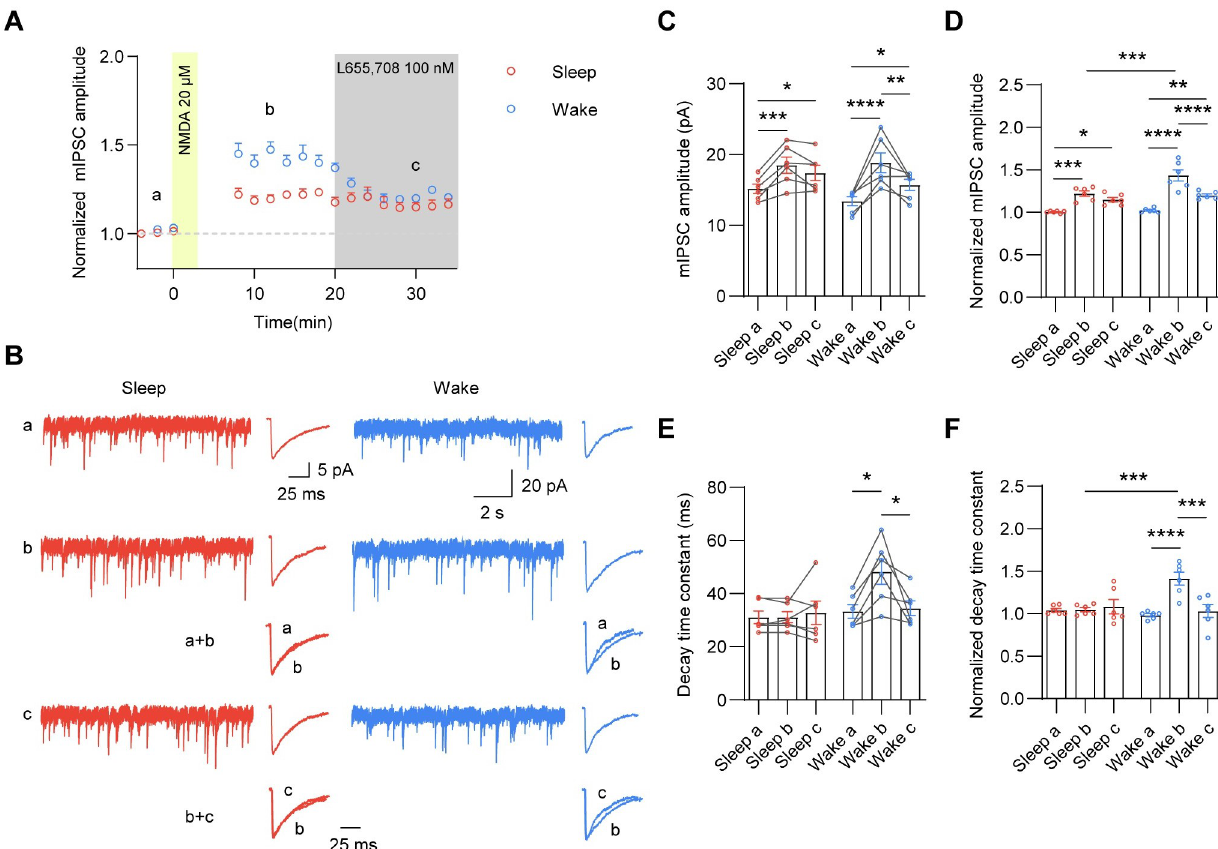
Fig 3. Synaptic recruitment of α 5-GABA A Rs contributes to wake-dependent enhancement of iLTP. (A) Time course of mIPSC amplitude in hippocampal CA1 pyramidal cells before and after NMDA application. α 5-GABA A R inverse agonist L655,708 was applied 20 min post-NMDA application. The data were binned into 2-min time bins. (B) Representative mIPSC traces and average mIPSC traces at indicated time points in (A) from the CA1 pyramidal neuron in acute hippocampal slices prepared from sleep and wake mice. a+b indicated peak-scaled overlays showing the difference of decay time constants between time points a and b. b+c indicated peak-scaled overlays showing the difference of decay time constants between time points b and c. (C) L655,708 decreased mIPSC amplitude after NMDA application in wake mice but not sleep mice. ( n = 6, 2-way ANOVA, F (2, 20) = 34.77, p < 0.0001 with Sidak’s multiple comparison test, Sleep a versus Sleep b, p = 0.0007; Sleep a versus Sleep c, p = 0.0213; Wake a versus Wake b, p < 0.0001; Wake b versus Wake c, p = 0.0164; Wake a versus Wake c, p = 0.0013). (D) L655,708 decreased the potentiation of mIPSC amplitude after NMDA application in wake mice but not sleep mice. ( n = 6, 2-way ANOVA, F (2, 30) = 5.215, p = 0.0114 with Sidak’s multiple comparison test, Sleep a versus Sleep b, p = 0.0003; Sleep a versus Sleep c, p = 0.0237; Wake a versus Wake b, p < 0.0001; Wake b versus Wake c, p < 0.0001; Wake a versus Wake c, p = 0.037; Sleep b versus Wake b, p = 0.0002). (E, F) NMDA application enhanced mIPSC decay time constant in wake mice but not sleep mice. The wake- specific enhancement of mIPSC decay time constant was abolished by L655,708 (E: n = 6, 2-way ANOVA, F (2, 15) = 2.972, p = 0.0818 with Sidak’s multiple comparison test, Wake a versus Wake b, p = 0.02; Wake b versus Wake c, p = 0.038. F: n = 6, 2-way ANOVA, F (2, 15) = 9.892, p = 0.0018 with Sidak’s multiple comparison test, Wake a versus Wake b, p < 0.0001; Wake b versus Wake c, p < 0.0004; Sleep b versus Wake b, p = 0.0003). The data underlying this figure can be found in S1 Data. � p < 0.05, �� p < 0.01, ��� p < 0.001, and ���� p < 0.0001. All data are presented as mean ± SEM. iLTP, inhibitory long-term potentiation; mIPSC, miniature inhibitory postsynaptic